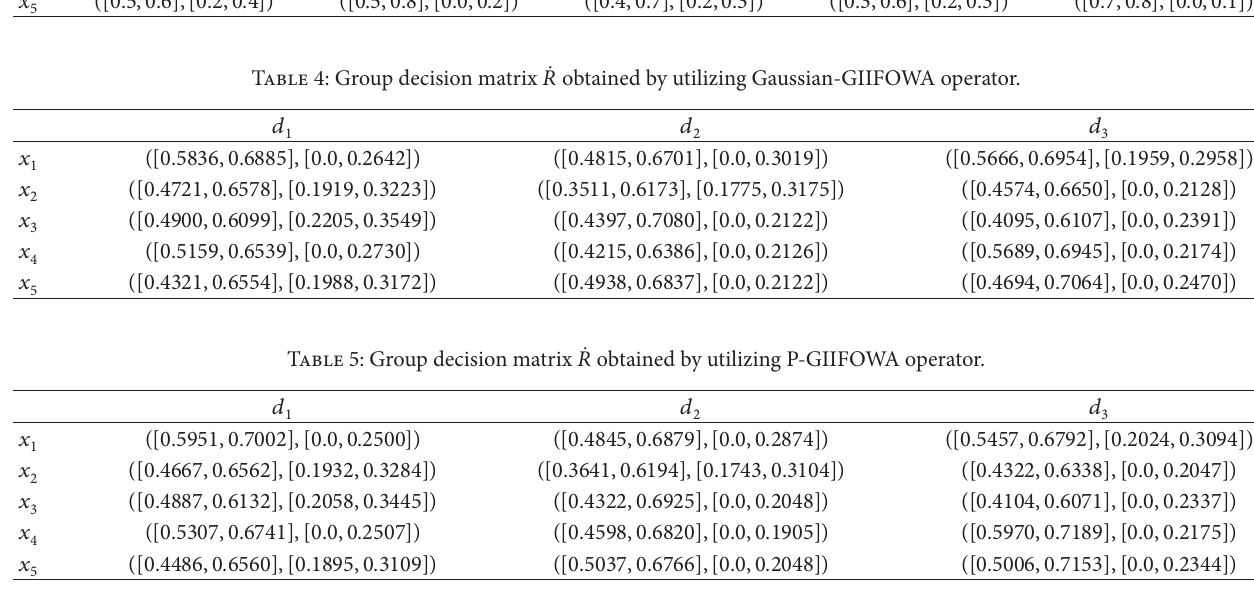
̇𝑅 obtained by utilizing Gaussian-GIIFOWG